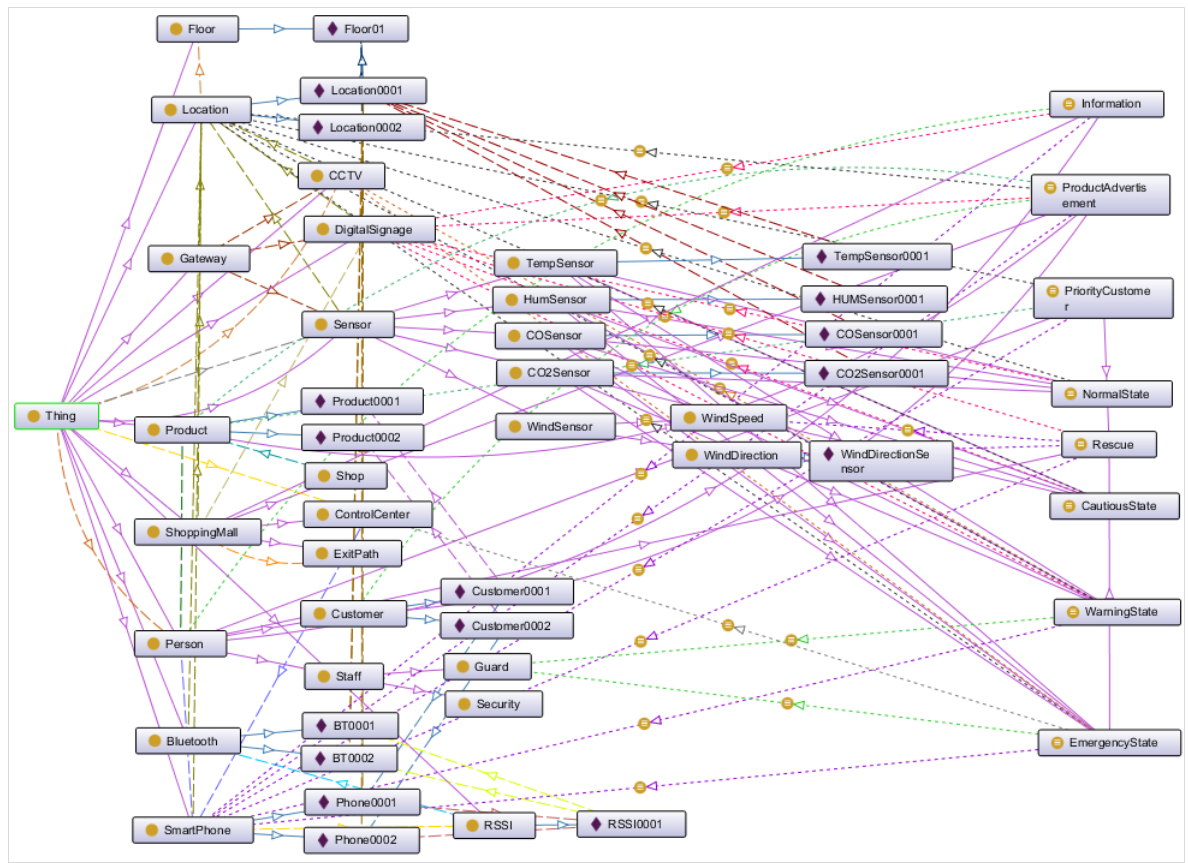
Figure 20. Semantic ontology model for the use case at a smart shopping